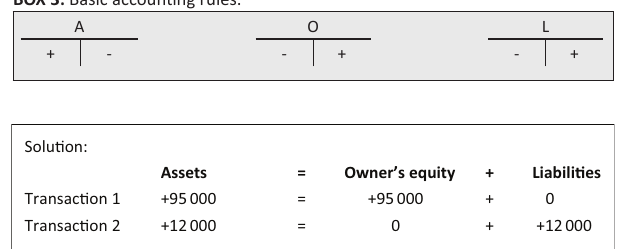
FIGURE 15: Basic accounting equation